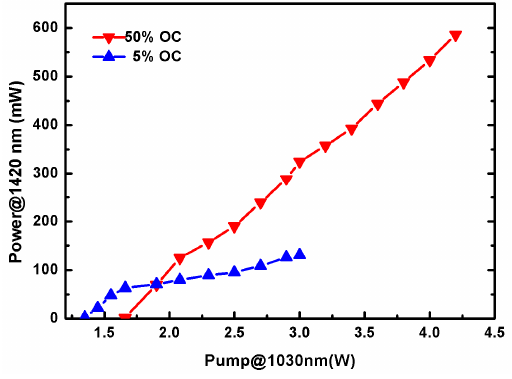
Figure 5. Output power of the 2nd Stokes (1420nm) vs. Pump power with 5% and 50% OC.